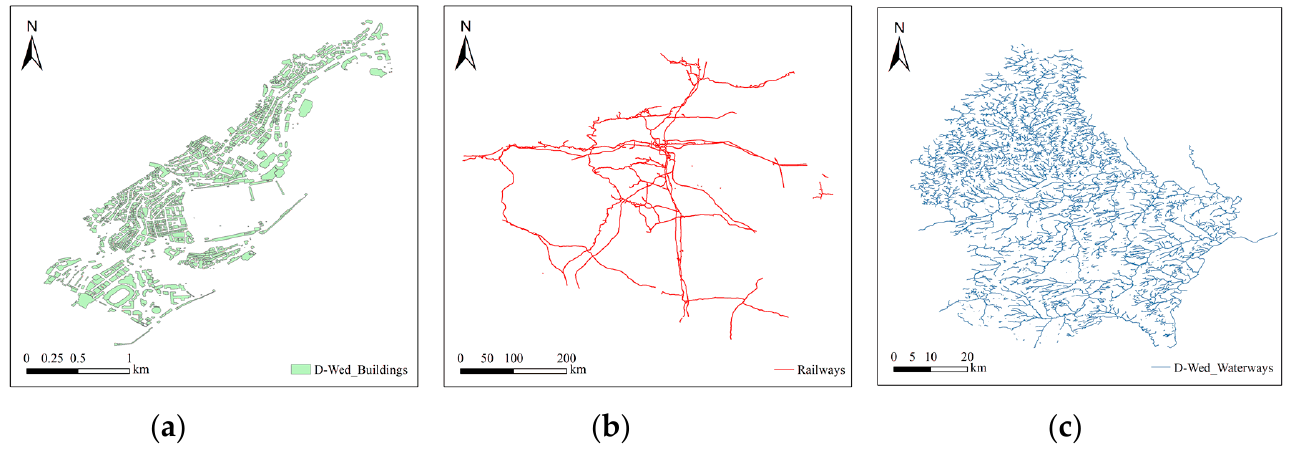
Figure 8. The visualization results of D-Wed maps: ( a ) D-Wed buildings, ( b ) D-Wed railways, ( c ) D-Wed waterways.